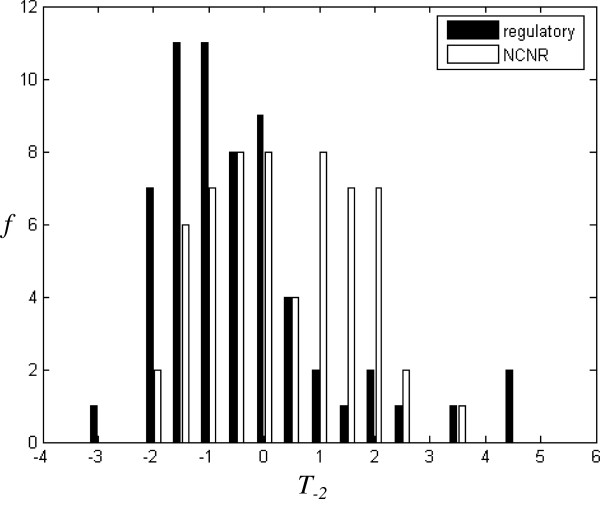
Histograms for CRMs and NCNRs classified by T50(m = 5, j = 1).